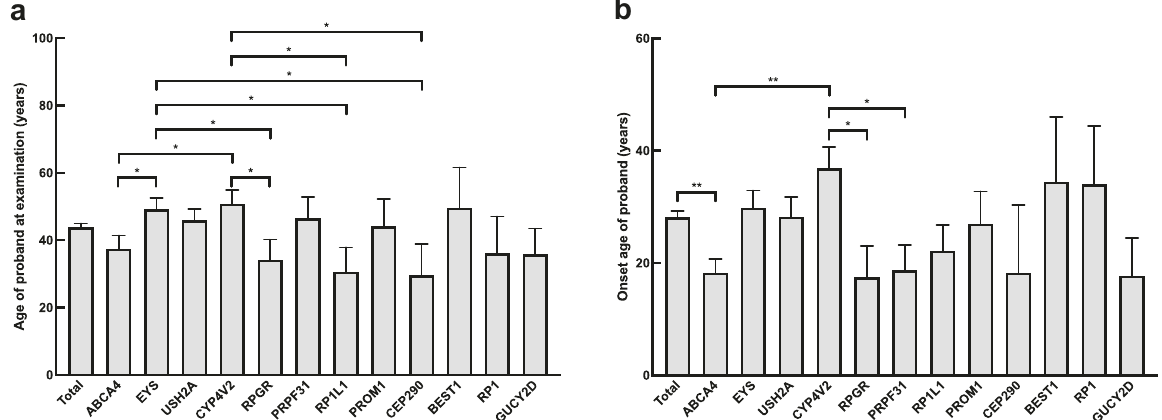
Fig. 4 The age at examination and age at onset of IRD probands grouped by the disease-causing gene. a The age at examination of all probands. b The onset age of all probands. Mean with different symbols are statistically signi fi cant compared to all probands by Fisher ’ s LSD test (** p < 0.01; * p <